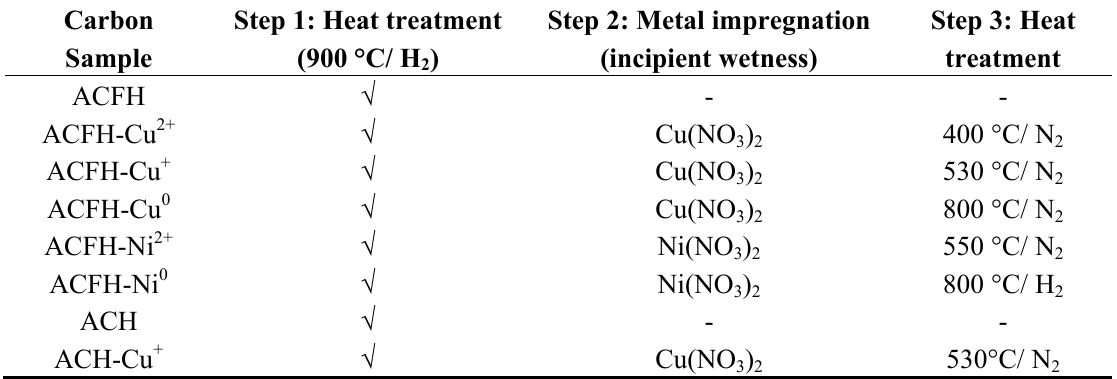
Table 1. Preparation steps of carbon samples impregnated with copper or nickel